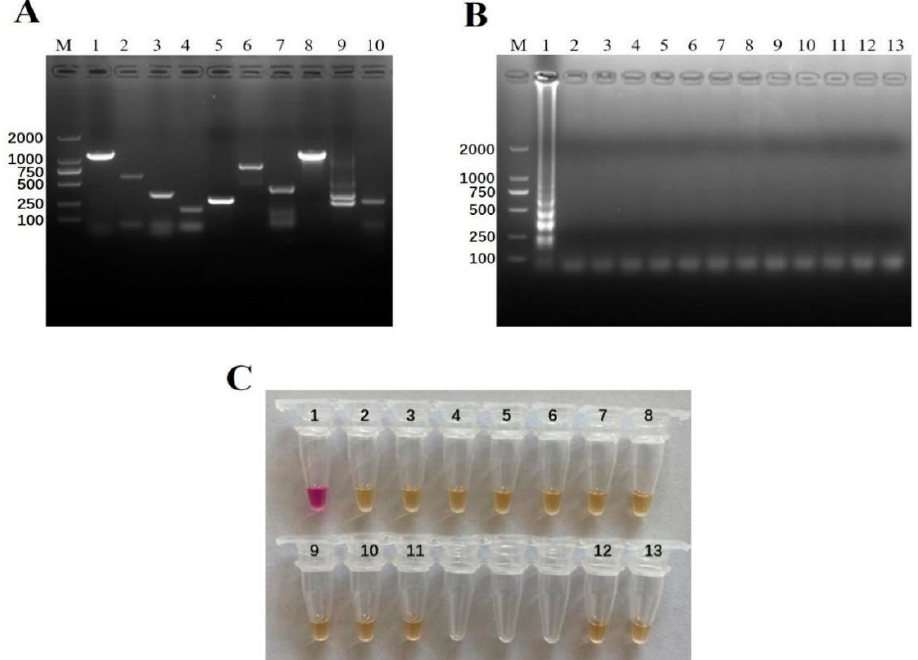
Figure 4. The analytical specificity of the naked-eye visual RT-LAMP assay. ( A ) Electrophoresis of self-identification of the viruses for cross-reaction analysis by the specific PCR or RT-PCR. Lane 1–10 were ORFV (1137 bp), SPPV (600 bp), PRV (356 bp), PCV2 (250 bp), BVDV (300 bp), SVV (800 bp), CSFV (424 bp), BTV (1200 bp), PRRSV (245 bp, 335 bp) and PPV (445 bp). Lane M, DL2000 DNA marker (Takara, Dalian, China). The identified viruses above were subject to the naked-eye visual RT-LAMP assay for FMDV detection. The amplified products were shown by agarose gel electrophoresis ( B ) and naked-eye examination in ambient light ( C ), respectively. Among them, No. 1–11 represented FMDV, ORFV, SPPV, PRV, PCV2, BVDV, SVV, CSFV, BTV, PRRSV, and PPV, respec ‐ tively. No. 12–13 represented cell culture supernatant and ddH 2 O as the negative controls. M: DL2000 DNA marker (Takara, Dalian, China).